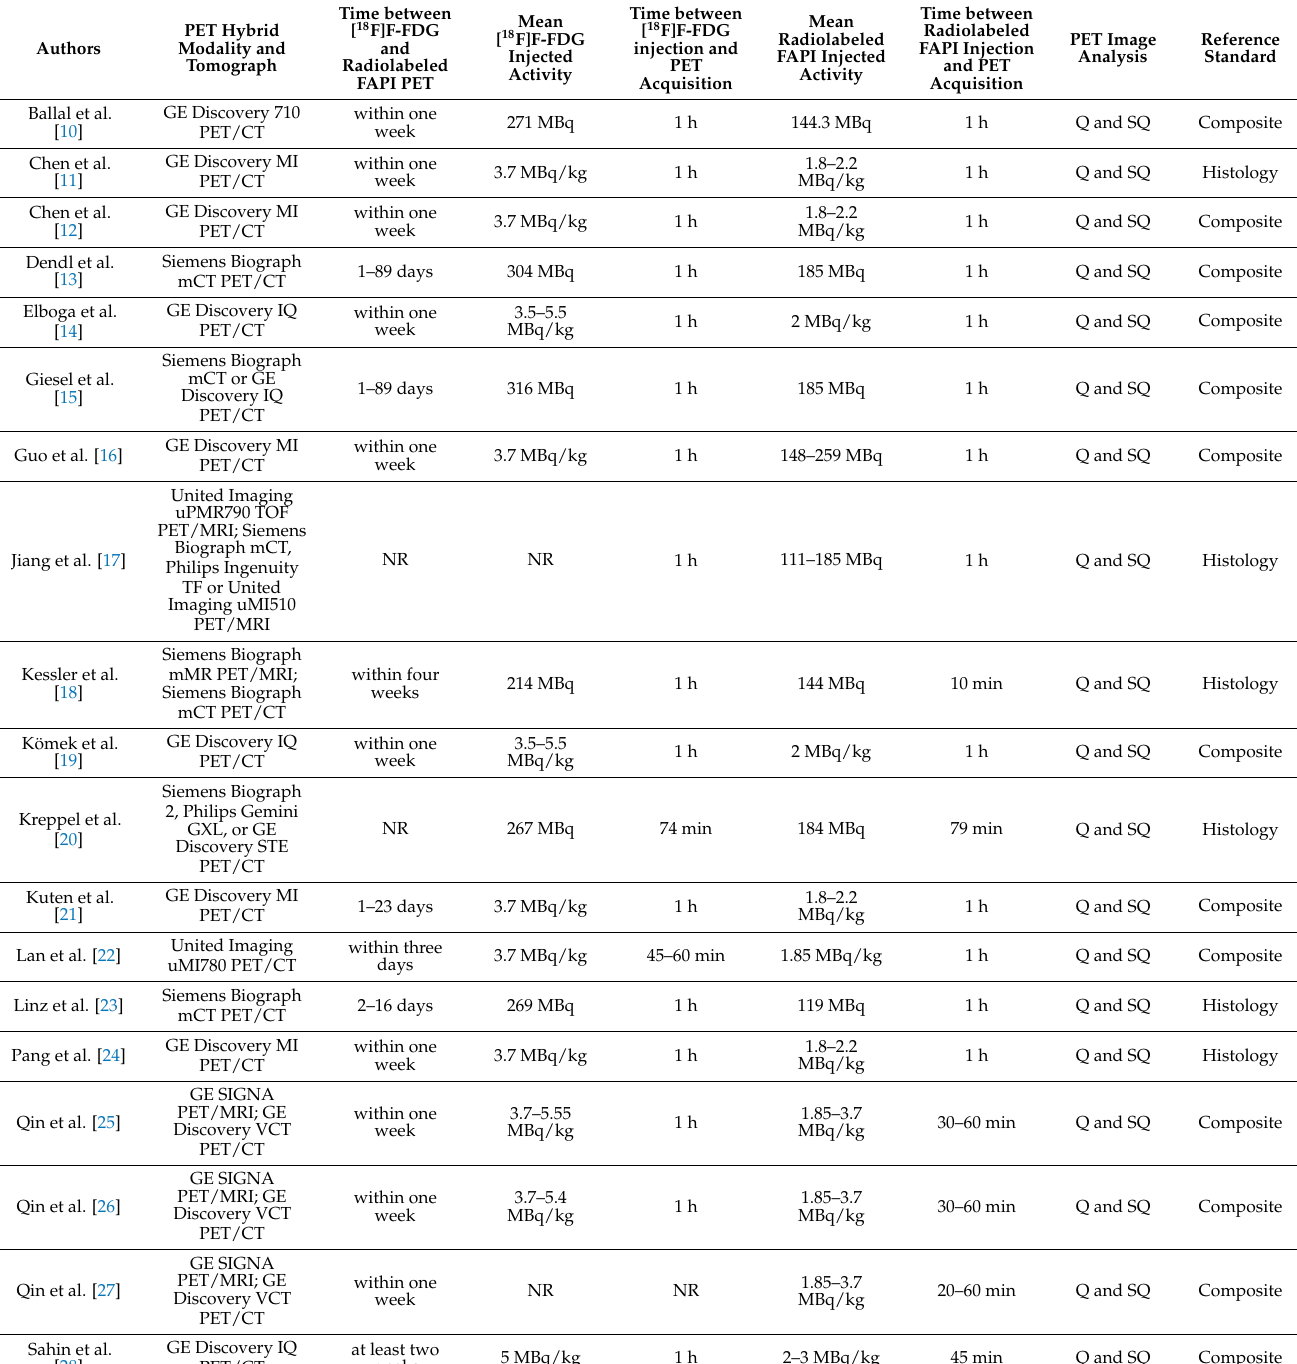
Table 2. Technical aspects of the included